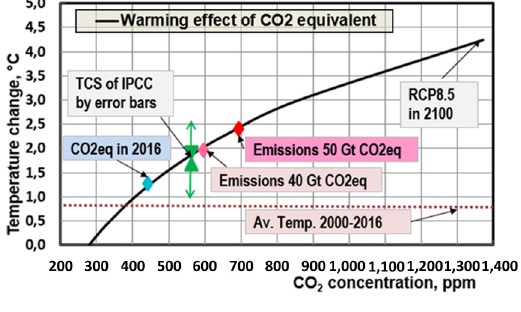
Figure 1. The warming effect of carbon dioxide (CO 2 ) according to IPCC